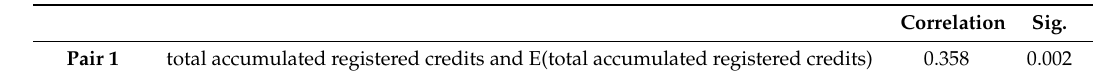
Table 4. Paired sample